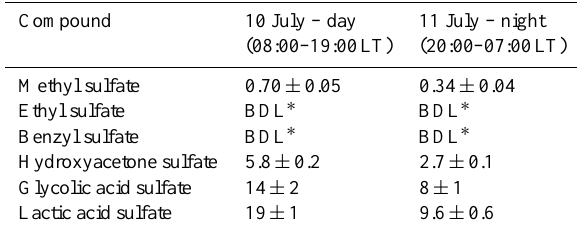
Table 2. Ambient concentrations of organosulfates with analytical uncertainties (ngm − 3 ) measured in PM 2 . 5 from Centreville, AL in